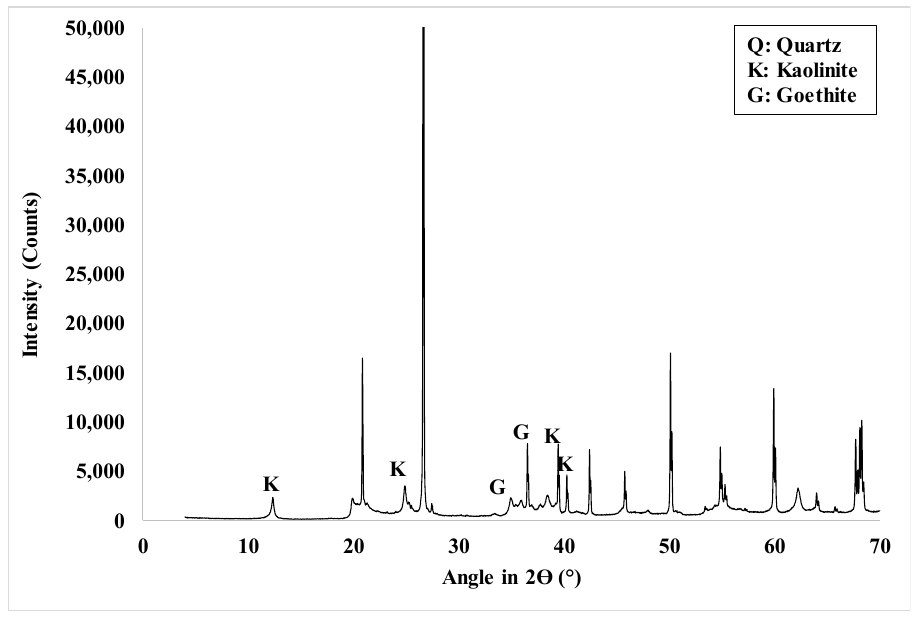
Figure 3. XRD pattern of Louaga soil. The mineralogical characterization of the Louaga sample was completed by DSC-TGA. The DSC-TGA curves (Figure 4) show an endothermic peak at around 100 ◦ C followed by a mass loss of 0.4 wt.% linked to the dehydration of the sample. The peak around 250 ◦ C corresponding to a mass loss of 1.8 wt.% was due to the dehydroxylation of goethite and its transformation into hematite (event 1). The large endothermic peak between 330 and 570 ◦ C with a mass loss of 5.4 wt.% was due to the dehydroxylation of kaolinite and its transformation to metakaolinite (event 2). This peak appeared at low temperature (less than 600 ◦ C) because of the low crystallinity of the kaolinite, which was disordered